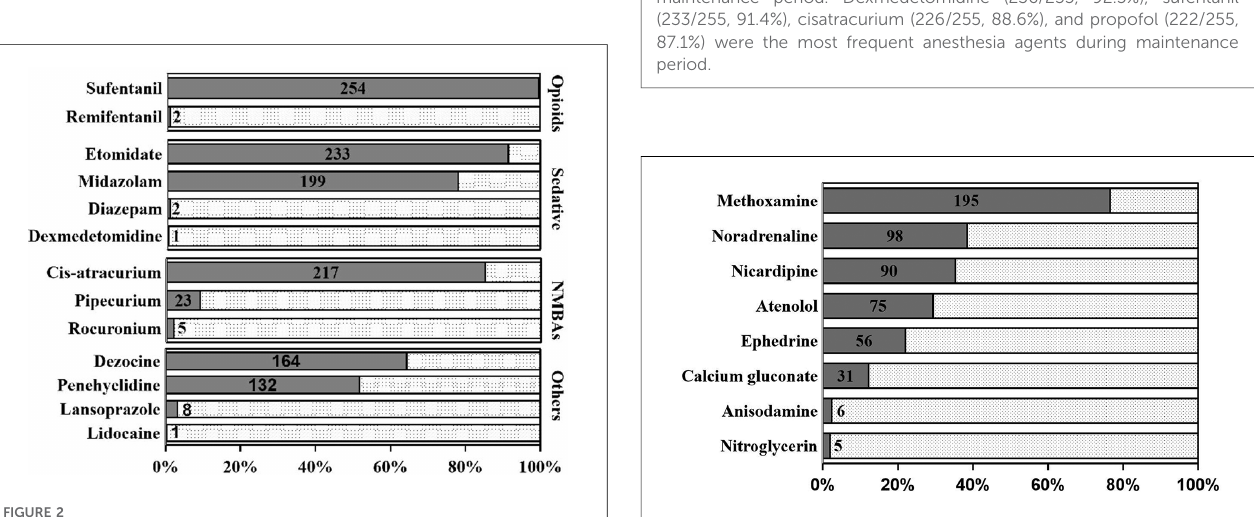
FIGURE 4 Inotropic and vasoactive agents (bonus). Methoxamine (195/255, 76.5%) and norepinephrine (98/255, 38.4%) were the most common vasoconstrictors with a fashion of bonus when hypotension occurred.